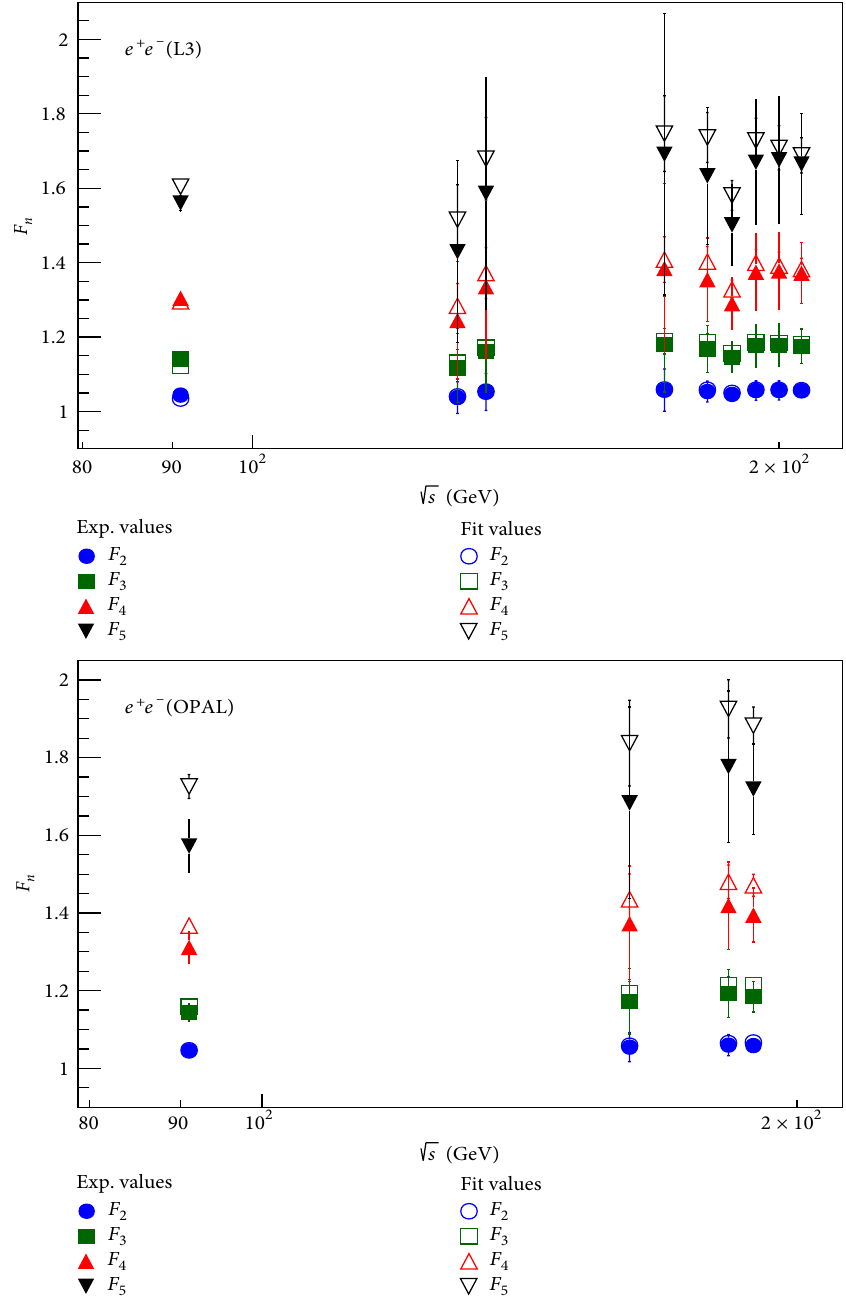
Figure 4: Normalized factorial moments of shifted Gompertz distribution for the at different